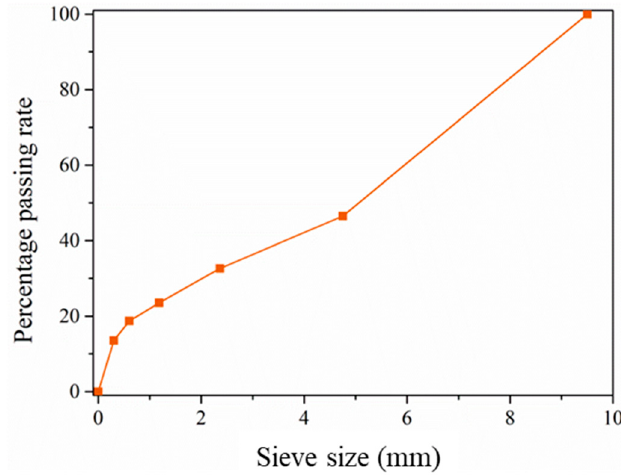
Figure 1. Percentage passing rate of aggregate.